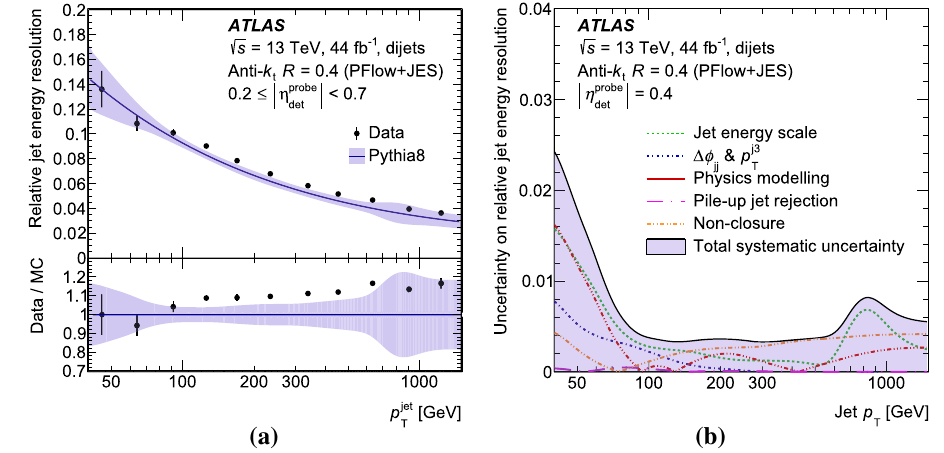
Fig. 26 a Relative jet energy resolution and b absolute uncertainty in the relative resolution as a function of p T for PFlow jets in the central region of the detector, measured using the dijet balance method. The resolution in data is shown in black points with error bars indicating sta- tistical uncertainties; the resolution in detector-level simulated events is shown by the blue curve with total systematic uncertainty given by